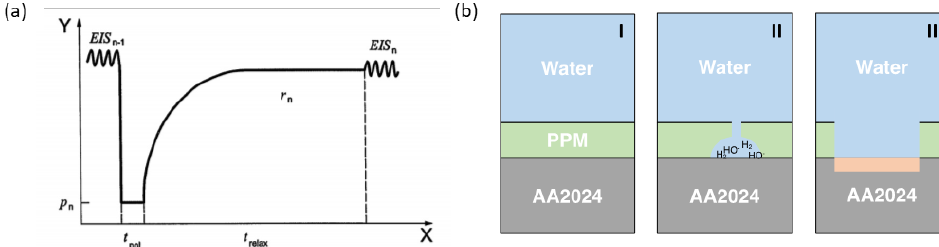
Figure 2. ( a ) Scheme of the ACET test in which X is the experimental time, Y is the electric potential, p n represents the cathodic potential applied during the polarization step, t pot and t relax stands for the time of the polarization and relaxation, respectively. ( b ) Schematic representation of coating life, (I) represents a healthy coating, (II) delamination and/or porosity formation with subsequent blister- ing, (III) corrosion propagation.